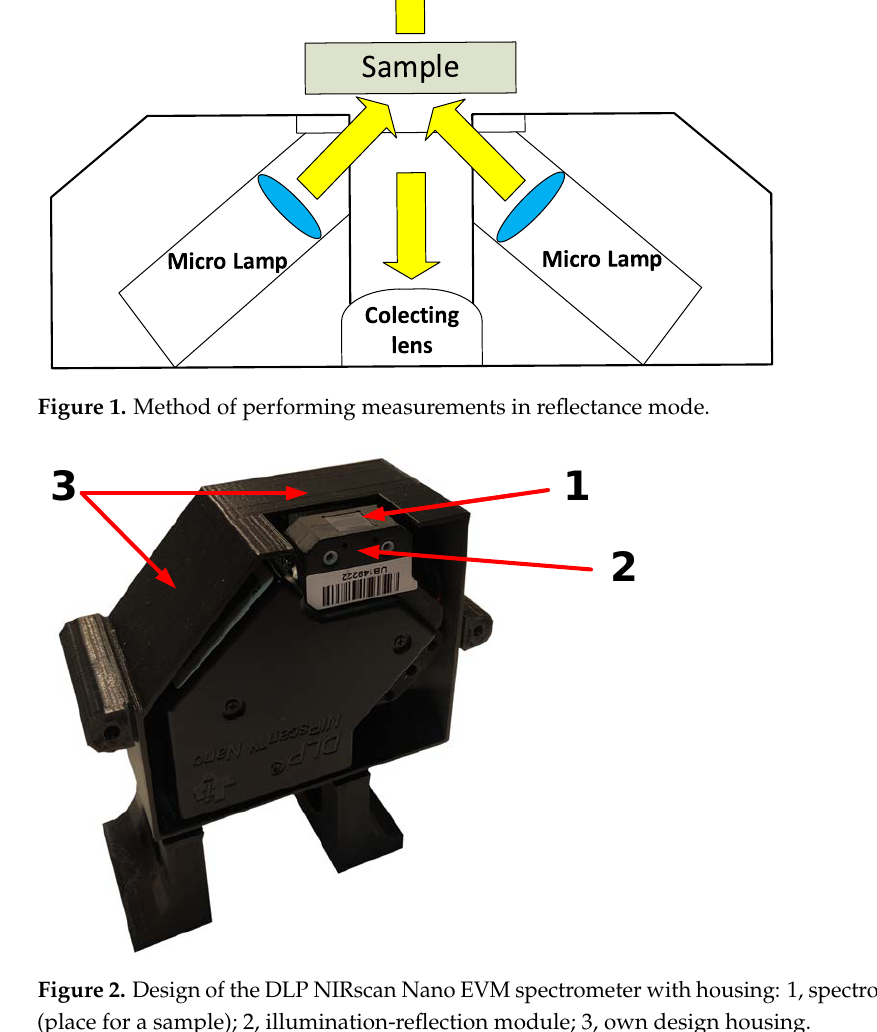
Figure 4. Actual view of the test stand—additional adapters for DLP are shown. 3. Tested Objects The criterion for selecting objects was the variability of their optical characteristics in the time domain for several, ten or so, or tens of minutes. Biological materials, mainly the leaves of plants, were chosen as the test subjects, as the process of their aging over time is spectroscopically measurable. It is also an interesting group of objects because analysis of the aging process and the determination of freshness may be helpful in processing, trans- portation, and commerce. Each tested organic object has a characteristic range or several ranges in the reflectance spectrum where changes are the most visible. For plants having green leaves, this is typically the interval from 1400 to 1500 nm. In this light wavelength interval, significant changes occur in the measured reflectance value (as time passes, this value drops within the range mentioned above, pertaining to green plants (Figure 5)). This phenomenon may be caused by water absorption within this range. As the leaf withers,